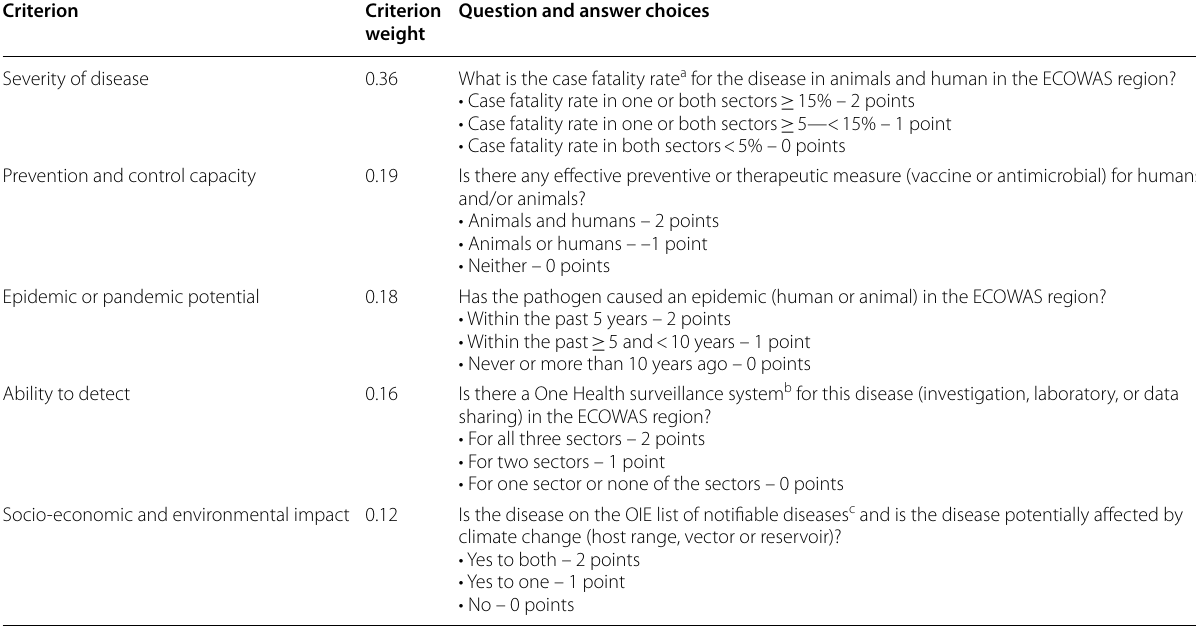
a If data from the ECOWAS region was not available, global data was used b If five or more ECOWAS countries had a surveillance system for a disease in a particular sector, the sector was considered to have a surveillance system for that disease c The OIE list was agreed upon by the Member States as a proxy to measure socio-economic impact